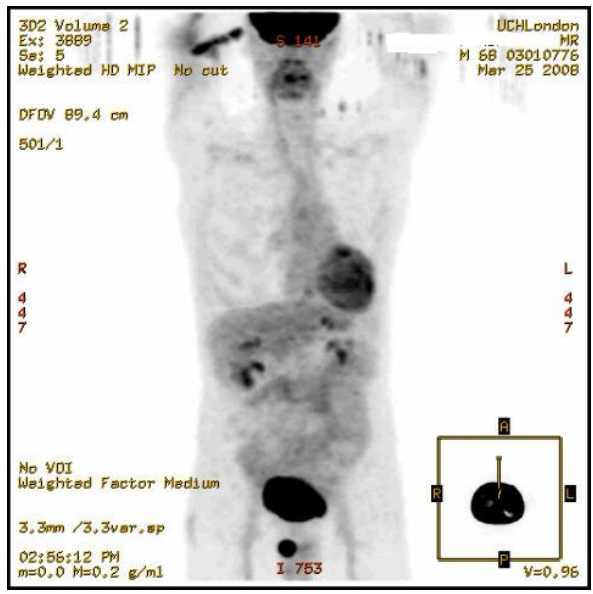
FIGURE 1 . FDG PET shows an avid lesion in the right cord and rules out the presence of involvement of the adrenal glands.